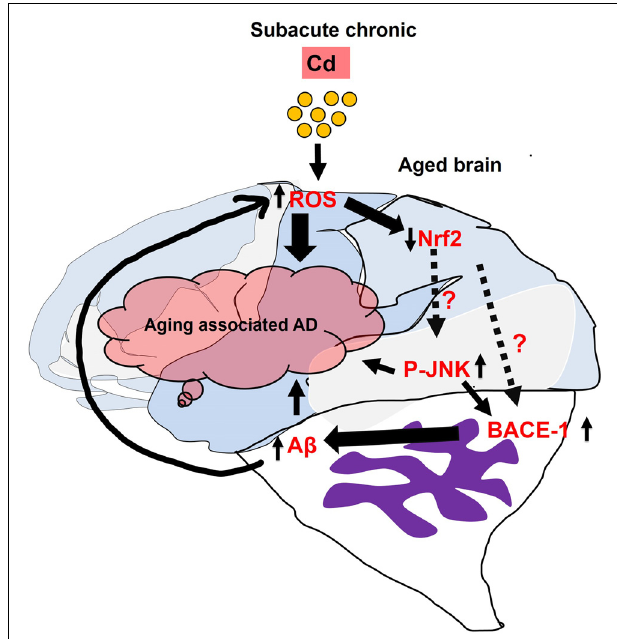
FIGURE 8 | Represents the generalized overview and possible mechanistic approach of subacute Cd administration which induced Alzheimer’s disease (AD)-associated pathologies in the aged mice’s brain. Represented that direct correlation and mechanism between the Nrf2 and p-JNK as well as their relationship with BACE-1 should be determined comprehensively in in vitro and in vivo